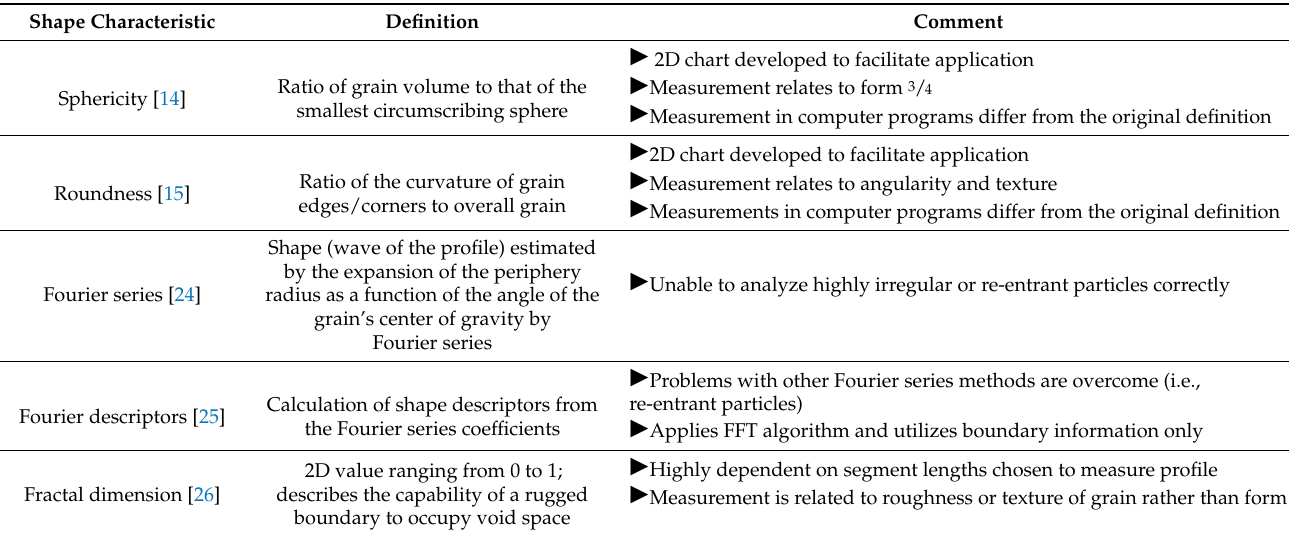
Table 3. Grain shape characterization methods (Adapted from [23]).